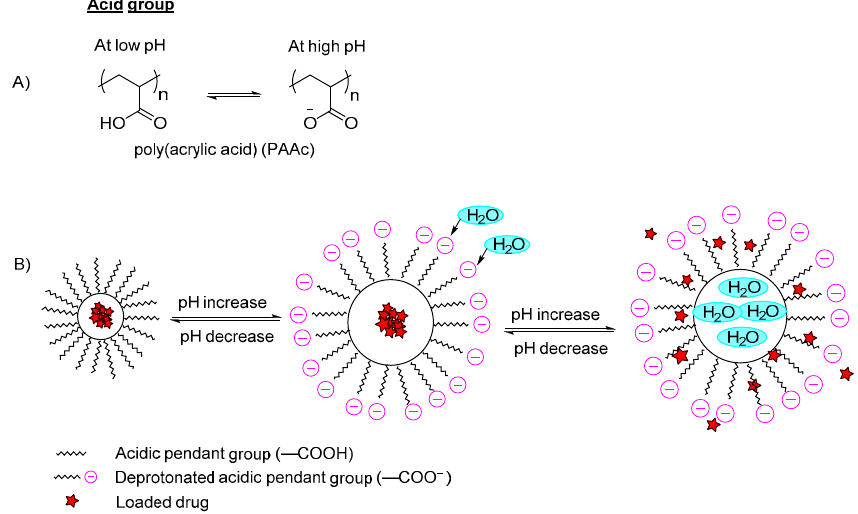
Figure 2. ( A ) An example of deprotonation of acidic group in a high pH medium; ( B ) An example of a polymer containing a carboxylic group (–COOH) with a model drug loaded. In the acidic pH medium, the pendant acidic group remains unionized and retains the drug in the polymer carrier. By increasing the pH, the pendant carboxylic group ionizes and deprotonates, and the polymer swells due to the increase of electron charge density, which induces water diffusion into the polymer network, releasing the incorporated drug.